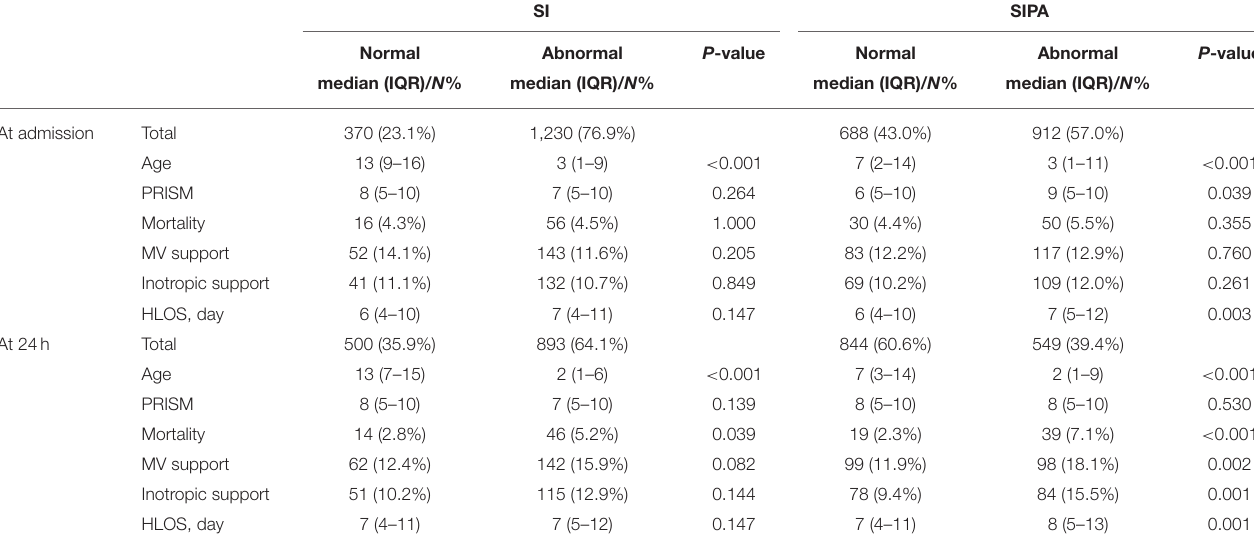
TABLE 3 | Correlation of SIPA at admission and 24 hours later with patient